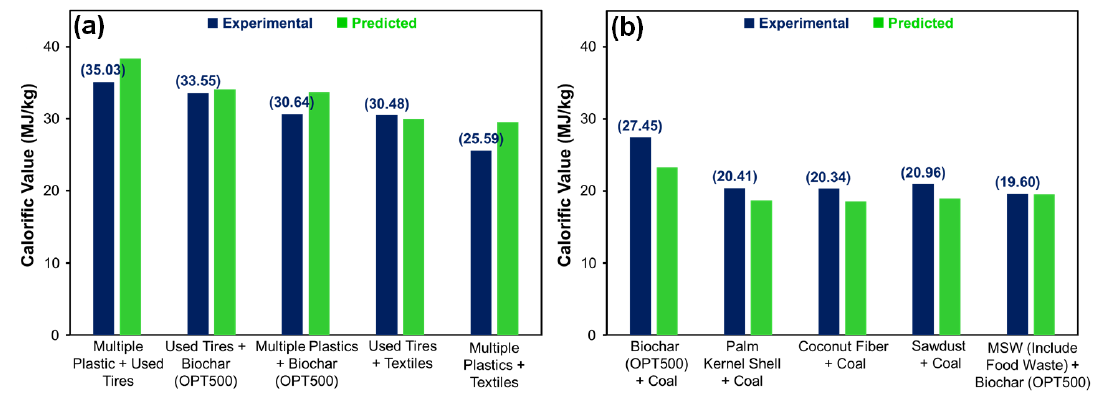
Fig. 3. Summary of the comparison between experimental calorific value and predicted calorific value for five sample combinations of (a) MSW and (b) biomass/biochar combinations.